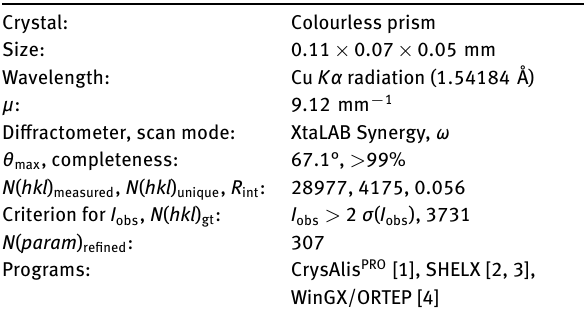
Table 1 contains crystallographic data and Table 2 contains the list of the atoms including atomic coordinates and dis- placement parameters.